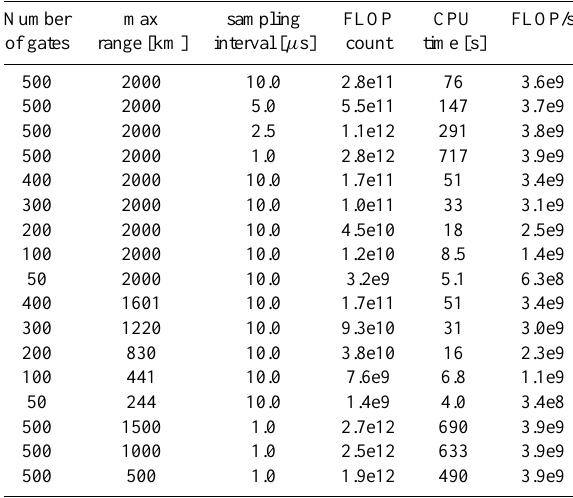
Table 3. Computing power needed for selected resolutions. All numbers are for one lag profile starting from 50km range. Integra- tion time is 2s. The CPU times are for one core of an 8 × 3GHz Eight-Core Intel Xeon desktop computer, 16GB 667MHz DDR2 FB-DIMM (Apple Mac Pro). The theoretically maximum possible FLOP/s rate of such a core is 4 times the CPU frequency assuming the vector SIMD SSE unit can operate at full speed making four 32-bit vector floating point operations each clock cycle. Thus the theoretical speed being 1.6e10 FLOP/s and the actual speed being about a quarter of that in many cases can be considered very satis-